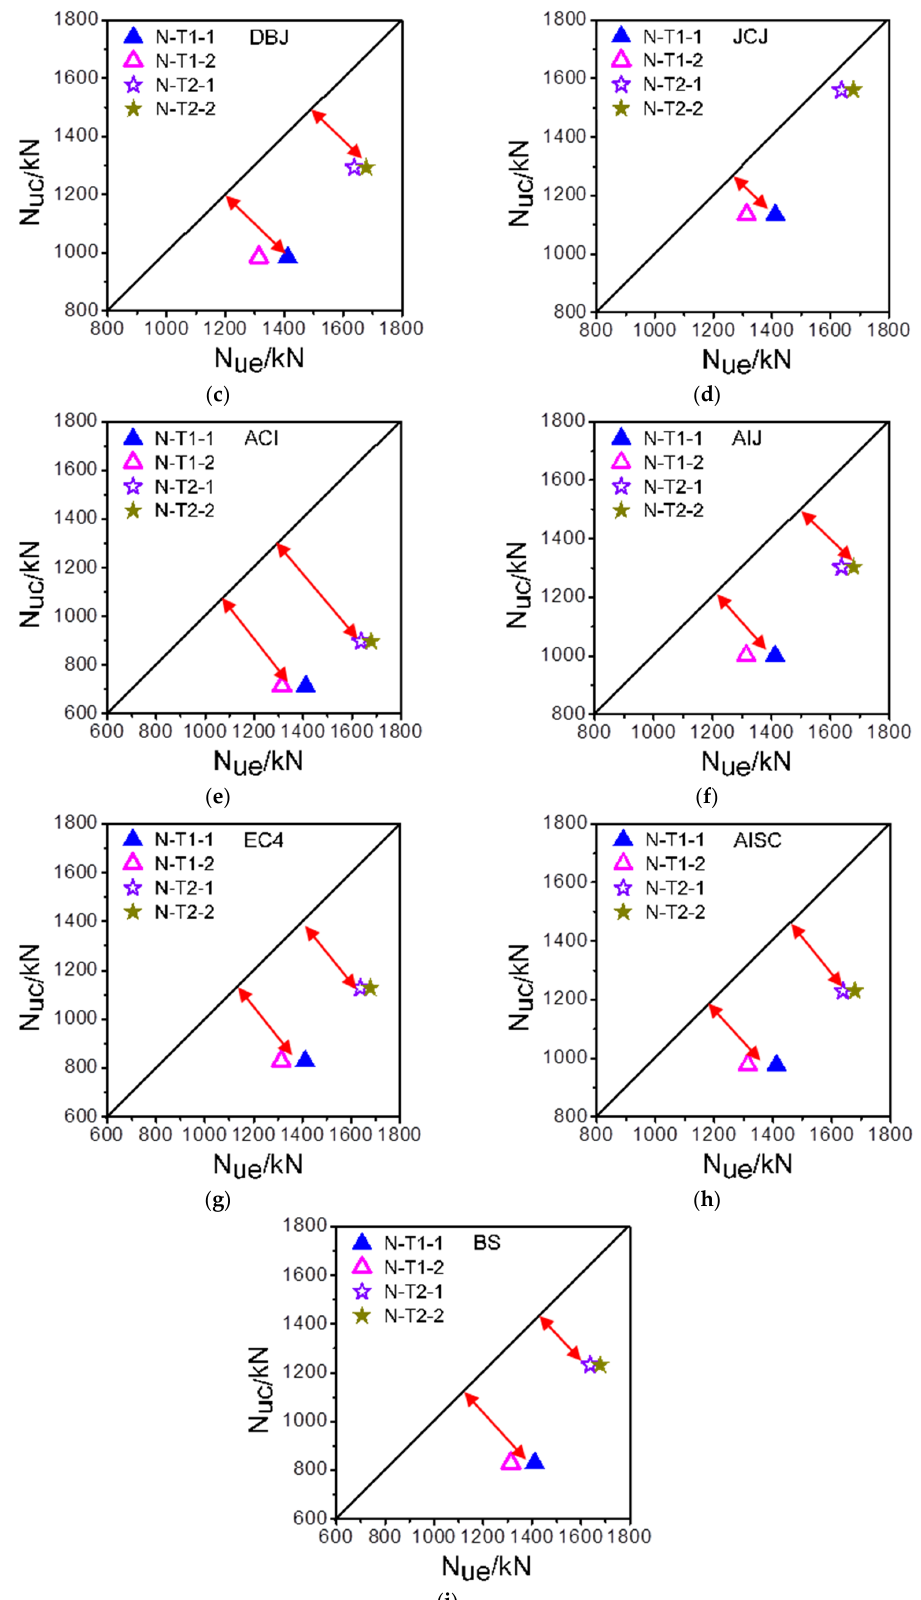
Figure 5. Comparison of the ultimate loads between experiments and calculated values by different design codes of the SCCFTST columns. ( a ) The experimental ultimate loads and theoretical